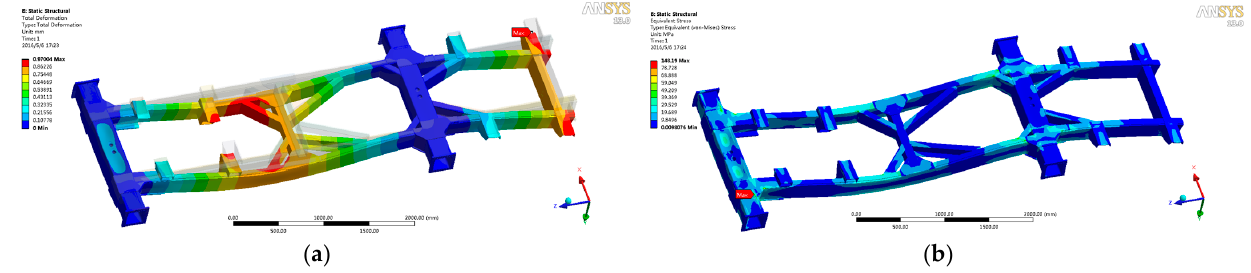
Figure 18. Results of static analysis of bending conditions after optimization. ( a ) Strain distribution map; ( b ) Stress distribution map. Table 6. Initial values of optimization variables and optimization results.